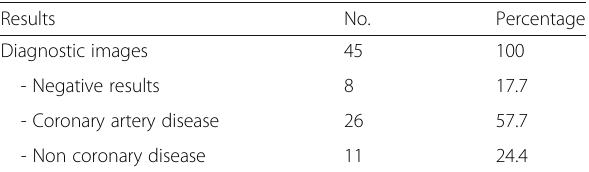
Table 2 Number of patients with coronary and non-coronary findings